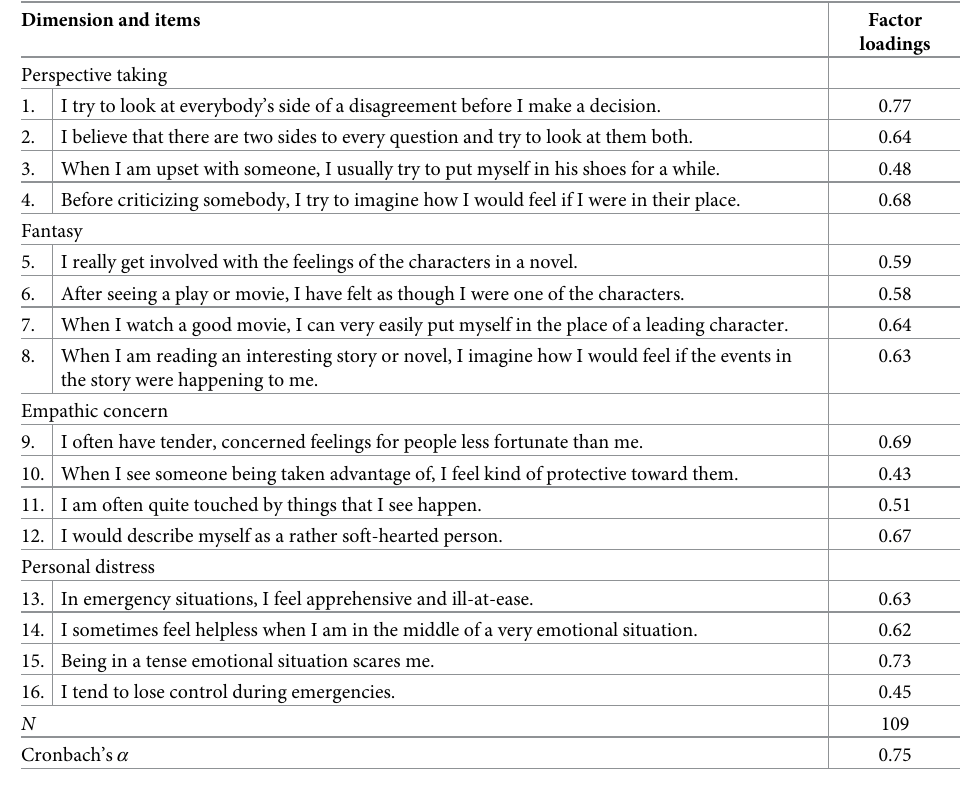
Table 1. The four dimensions of the Interpersonal Reactivity Index